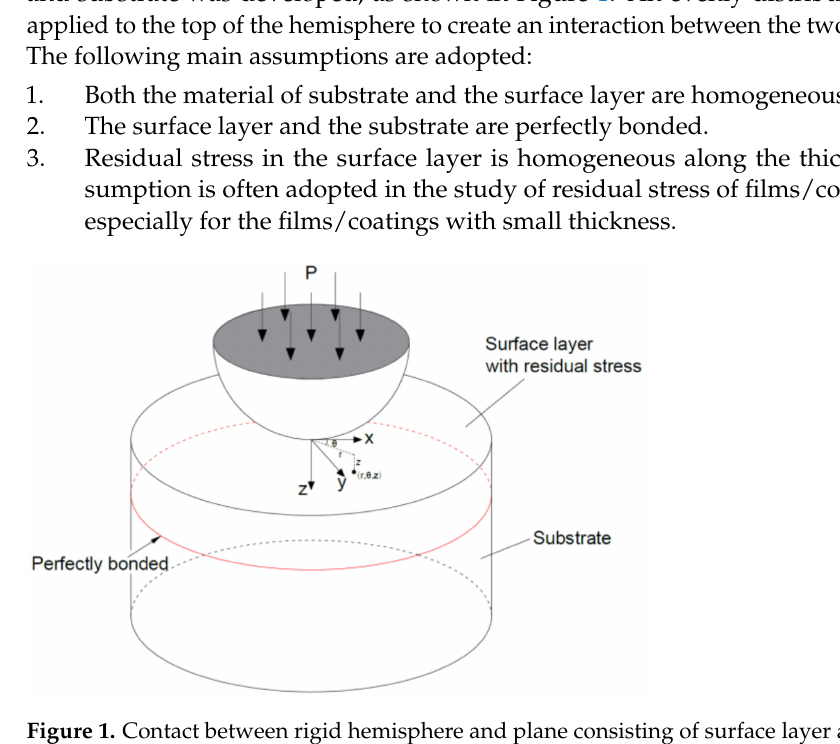
Figure 1. Contact between rigid hemisphere and plane consisting of surface layer and substrate. The contact was simulated using the finite element software ANSYS Workbench 16.0 (ANSYS Inc., Canonsburg, PA, USA). Considering the symmetry of the model, an axisymmetric 2D model was established. The boundary conditions are shown in Figure 2. Roller boundary conditions were applied on the axis of symmetry, bottom surface, and outer surface. For a practical surface layer and substrate system, the in-plane size is much larger than the surface layer thickness. The roller boundary condition on the outer surface is used to simulate the acting force of material out of the outer surface. It has been verified that free of the outer surface only led to stress concentration near the outer edge and had no significant effect on the stress field of the contact zone (see Appendix A). The friction coefficient between the contact pairs is set to be 0.15. The rigid hemisphere is modeled by setting the Young’s modulus to be significantly larger (1000 times) than that of the surface layer and